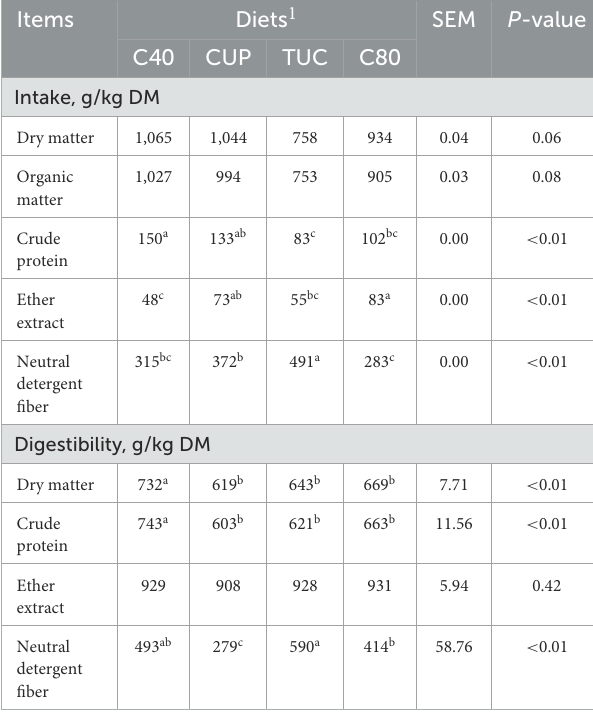
TABLE 3 Effect of the inclusion of Amazonian cakes on the intake and digestibility of nutrients of confined sheep.